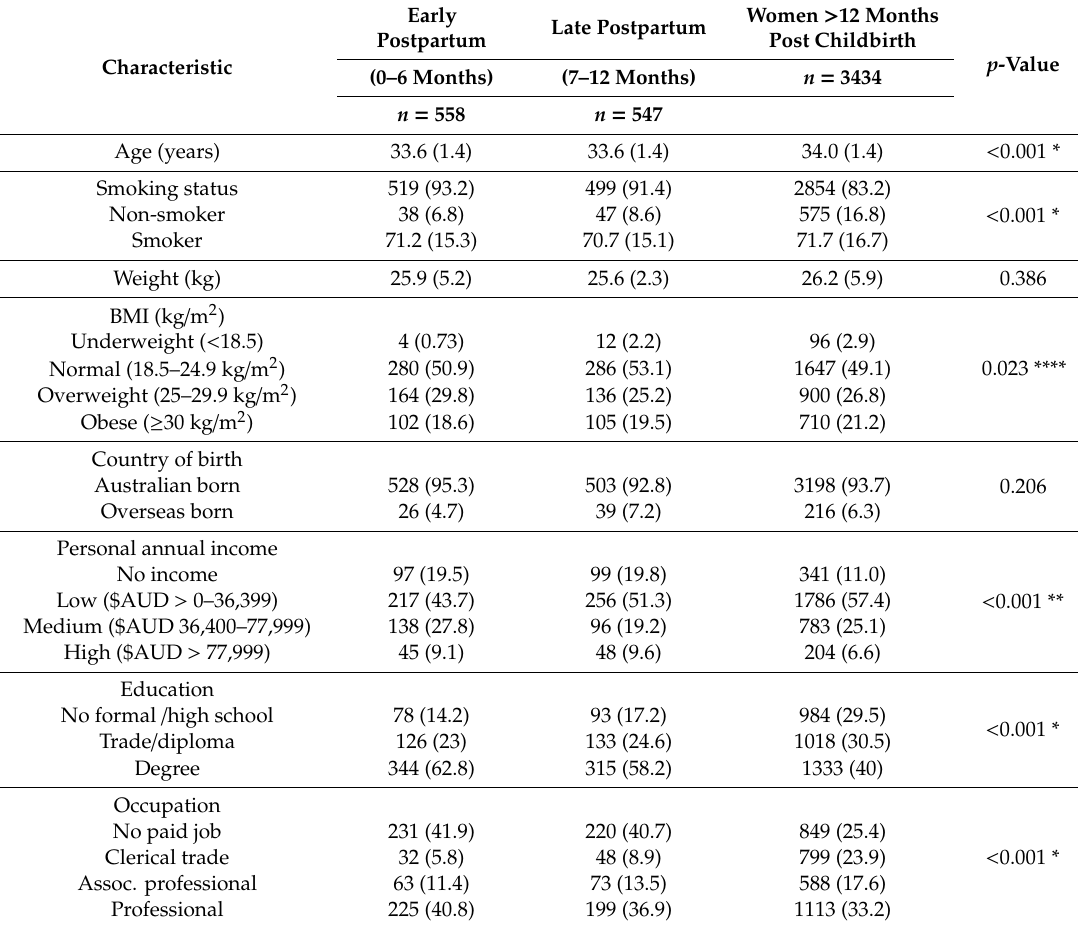
Table 1. Characteristics of women categorized by their time since childbirth.